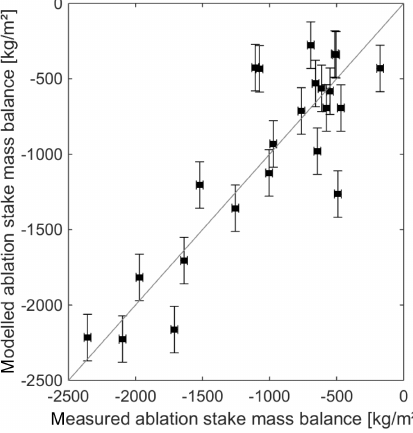
Figure 4. Model performance at the ablation stakes for the mass balance year